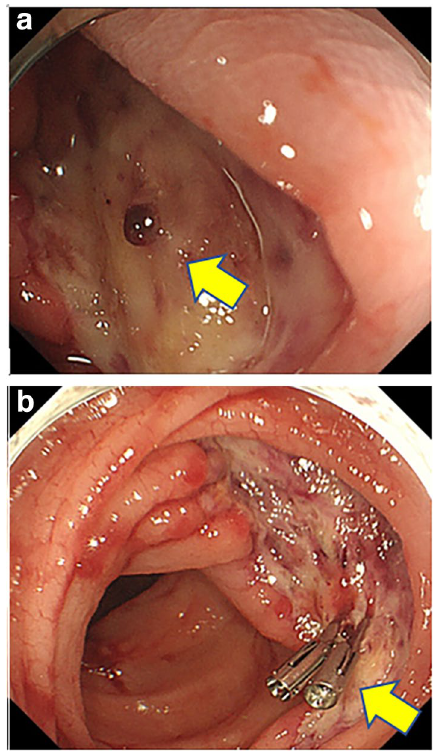
Figure 3. The images of a follow-up colonoscopy due to delayed bleeding. ( a ) Visible vessel on the artificial mucosal defect. ( b ) Hemoclips placed on the